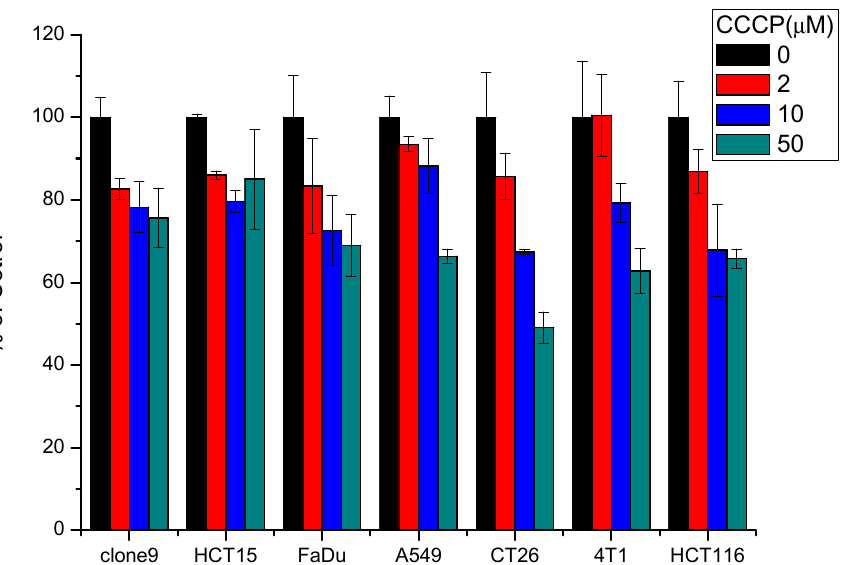
Figure 2. Representative uptake of 111 In-DOTA-NIR790 in various cancer cells treated with 0, 2, 10, and 50 µ M of carbonyl cyanine m-chlorophenylhydrazone (CCCP) ( n = 3 per concentration of CCCP and cell).